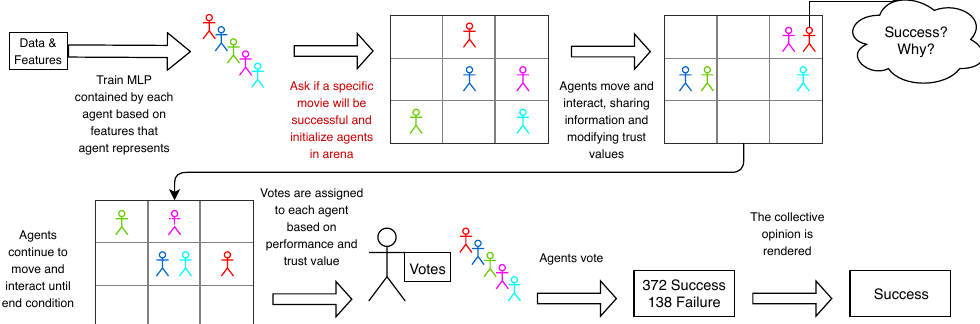
Figure 1. Agent training, initialization, movement, interaction, and voting.